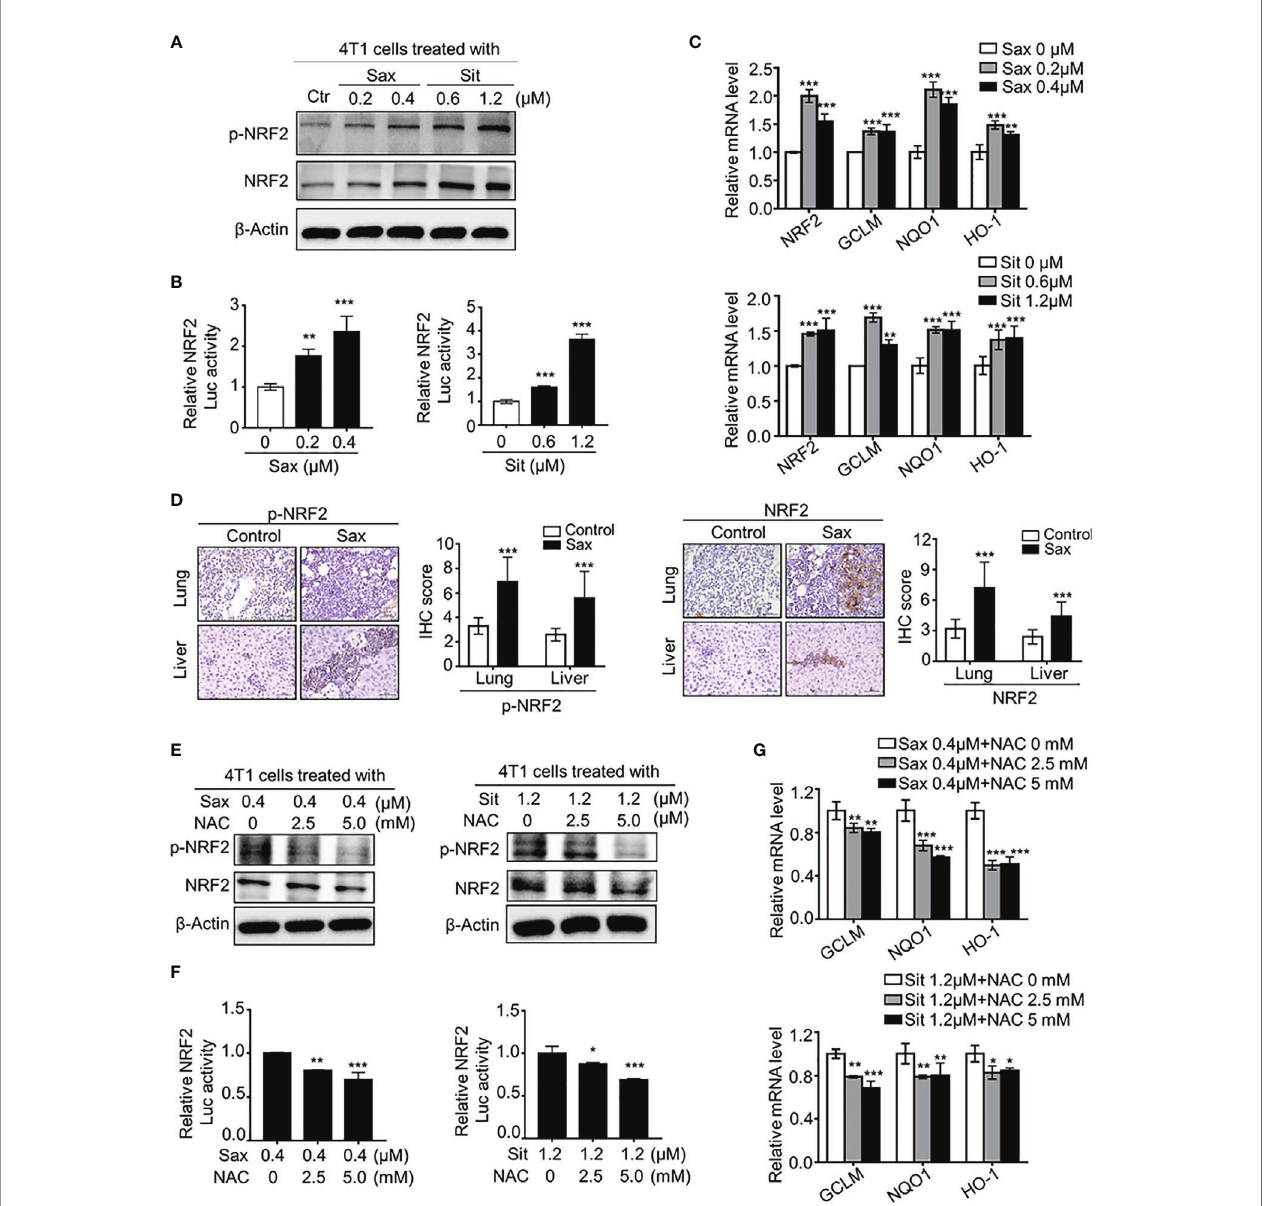
FIGURE 3 | DPP-4i induces ROS-dependent NRF2 activation. (A – C) DPP-4i enhances aberrant NRF2 activation of 4T1 cells in vitro. 4T1 cells were treated with DPP-4i. NRF2 and p-NRF2 expressions were detected by Western blotting (A) . NRF2/ARE transcriptional activation was analyzed by luciferase reporter gene assay (B) and NRF2-responsive genes levels were analyzed by Real-time PCR (C) . b -actin gene was as an internal control. (D) DPP-4i induces aberrant NRF2 activation in vivo. p-NRF2 and NRF2 proteins were detected by IHC staining in metastatic lung and liver tissues. (E – G) ROS scavenger abrogates DPP-4i-driven NRF2 activation. 4T1 cells were co-treated with DPP-4i and NAC. NRF2 and p-NRF2 expressions were detected by western blotting (E) . NRF2/ARE transcriptional activation was analyzed by luciferase reporter gene assay (F) and NRF2-responsive genes levels were analyzed by real-time PCR (G) . b -actin gene was as an internal control. Representative images are shown. Scale bars: 50 m m. Data are presented as mean ± SD of three independent experiments. *p < 0.05, **p < 0.01, and ***p < 0.001 between the indicated groups determined by unpaired Student ’ s t test or the one-way analysis of variance